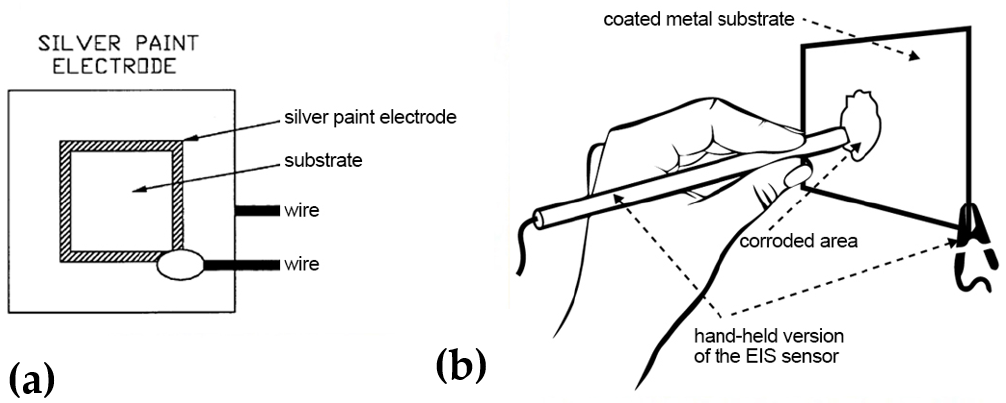
Figure 3. ( a ) The in-situ EIS sensor for measurements in the field. ( b ) The hand-held version of the EIS sensor for measurements in the field. (Personal drawing; inspiration from